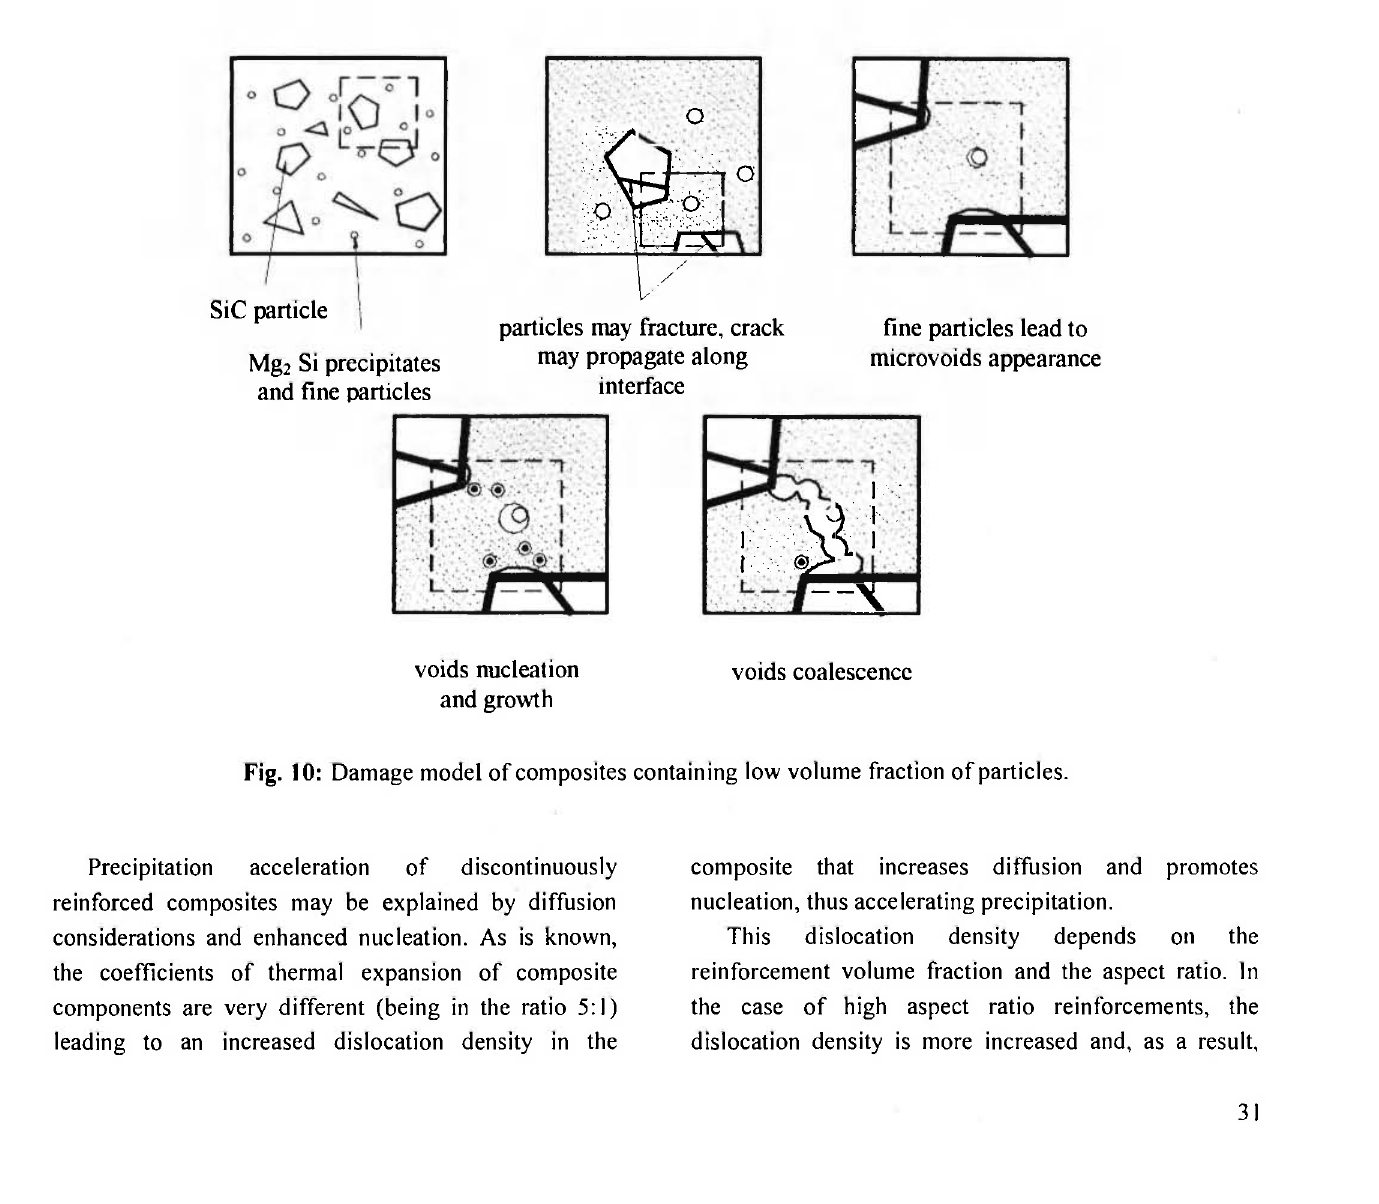
Fig. 9: Optical microstructure of as-cast, hot-rolled and peak-aged 6063A1 / 5% SiC p composite.